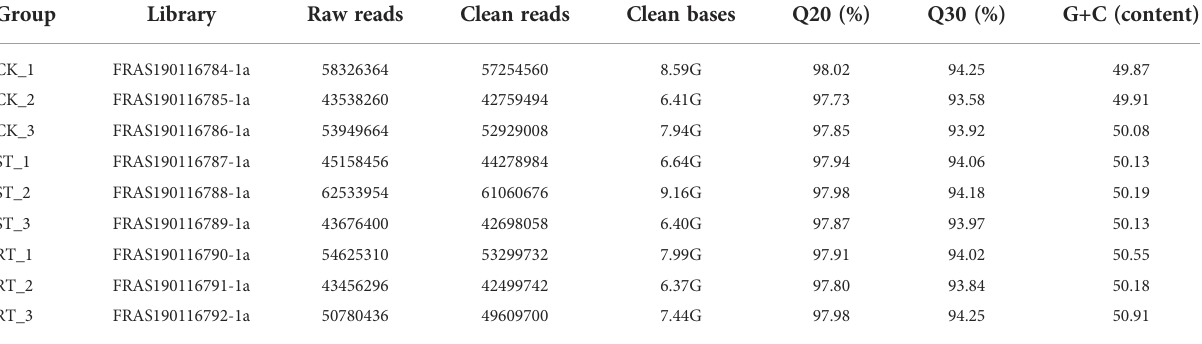
TABLE 4 Statistics of transcriptome data. Group